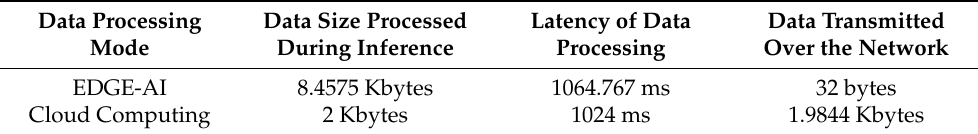
Table 11. Comparison between EDGE-AI and cloud computing modes of the STM32 Discover Kit IoT